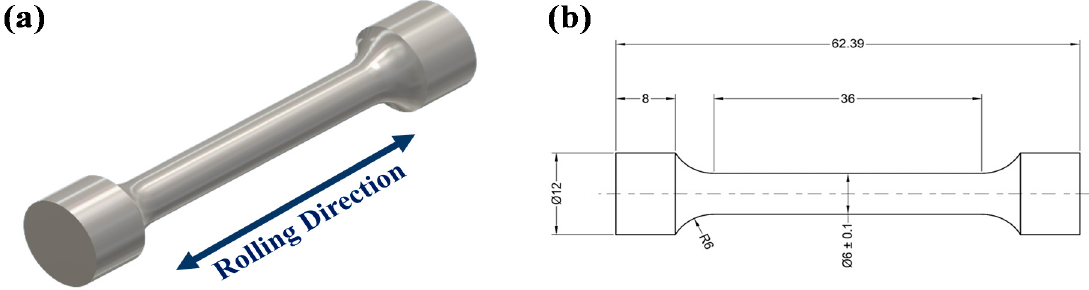
Figure 1. ( a ) Schematic illustration of the tensile specimens and ( b ) dimensions in mm of an ASTM-A370-20 (2020) test specimen.